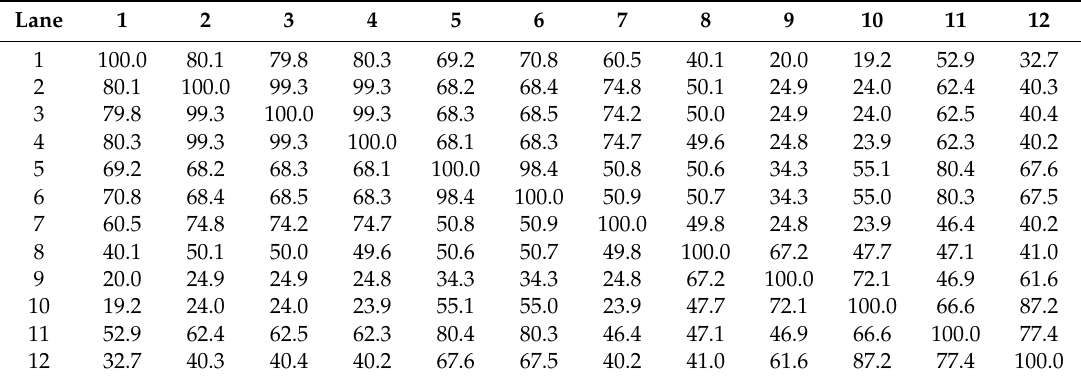
Figure 6. E ff ects of DHP on the ruminal bacterial community in dairy cows under HS conditions. ( A ) A representative agarose gel electrophoresis of rumen bacteria PCR products. Lanes 1-3 indicate electrophoresis results of PCR products from three di ff erent cows in the control group; lanes 4–6 indicate the electrophoresis results of three di ff erent cows in experimental group; M: DL2000 DNA marker. ( B ) Lanes 1–6 indicate the denaturing gradient gel electrophoresis (DGGE) results of PCR products from six di ff erent cows in the control group; lanes 7–12 indicate the DGGE results of PCR products from six di ff erent cows in the experimental group. Arrows indicate the bands of PCR products; ( C ) the number of DGGE bands in control group (S-ND) and the experimental group (S-D); ( D ) cluster analysis of the ruminal bacterial community between control group and experimental group. Table 4. Similarities in rumen bacterial community between control group and experimental